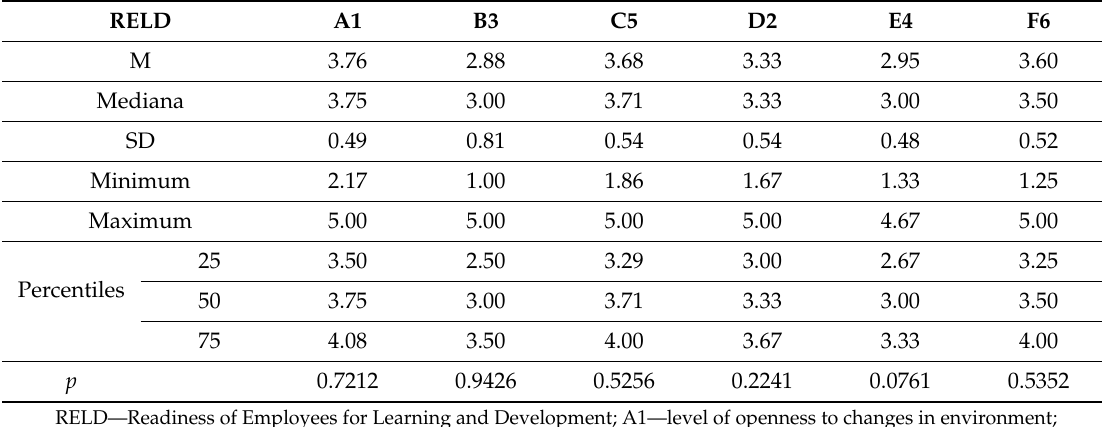
Table 1. Level of nurses’ readiness for learning and development